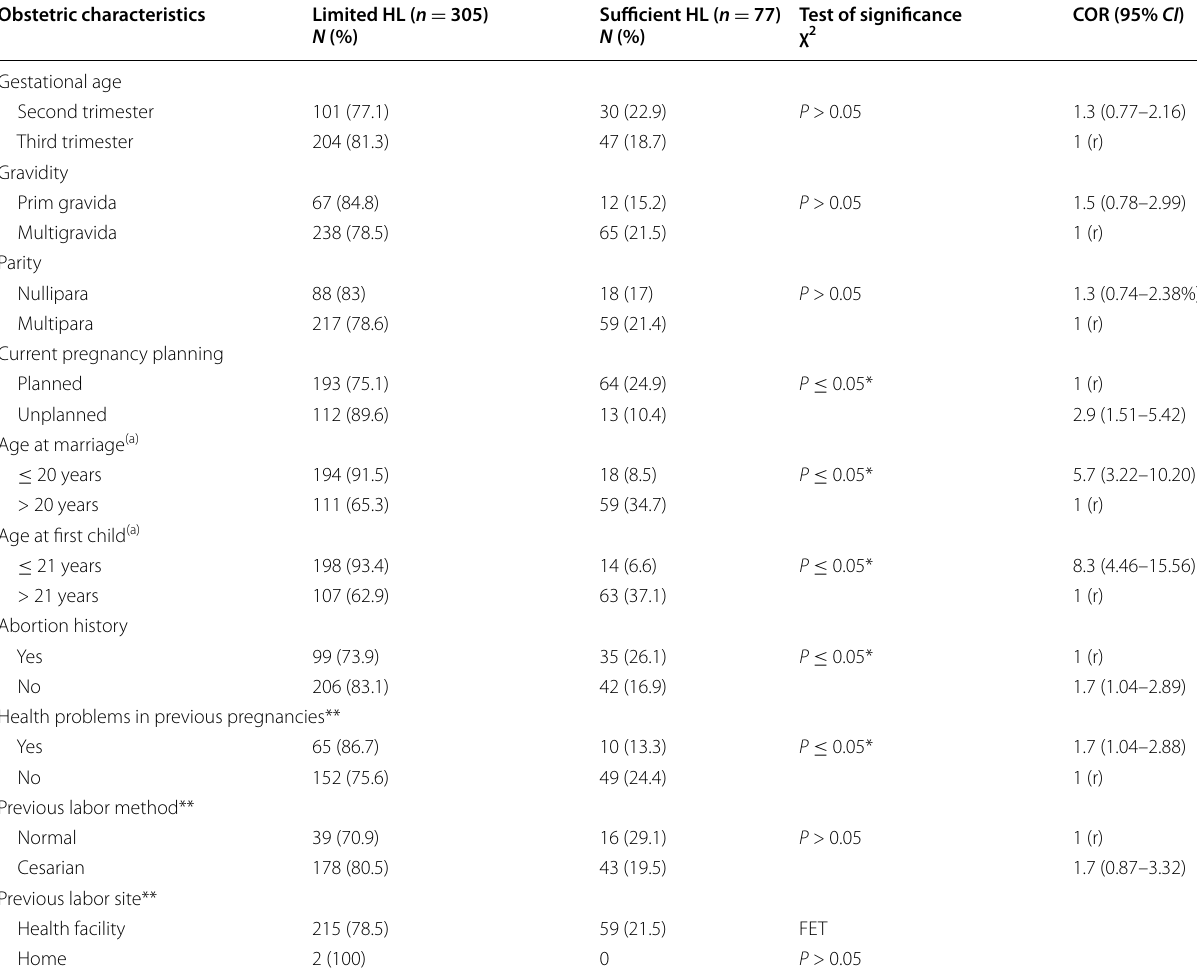
Table 3 Relationship between limited comprehensive HL and current obstetric characteristics of studied pregnant women attending ANC clinics in Mansoura district, Egypt, 2020 ( n =